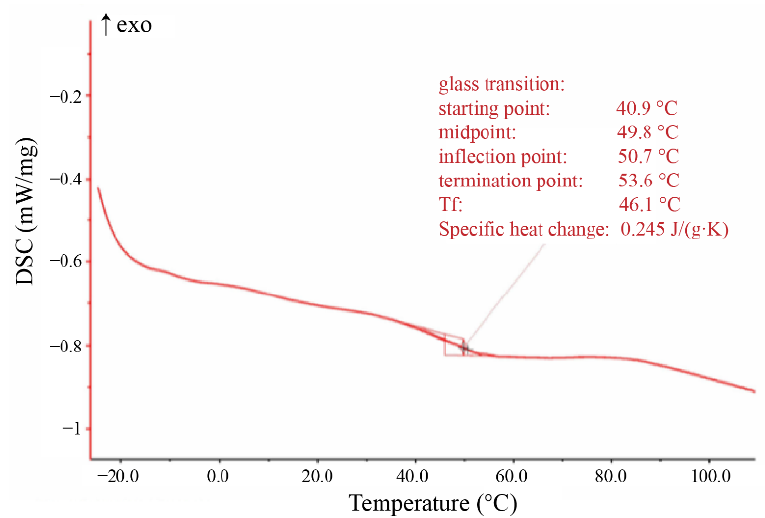
Figure 7. DSC of the hydroxyl-type waterborne acrylic acid